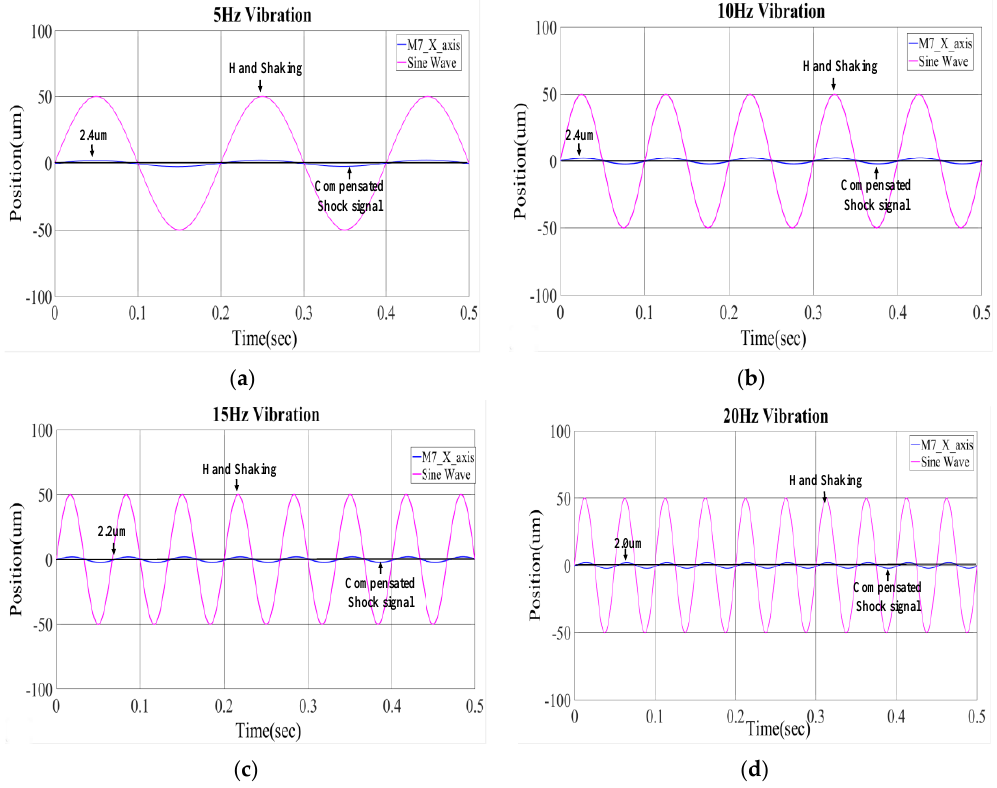
Figure 8. Simulated response of the lens holder motion relative to ground with the designed controller applied to the OIS; ( a ) 5 Hz disturbance in ±50 μm; ( b ) 10 Hz disturbance in ±50 μm; ( c ) 15 Hz disturbance in ±50 μm; ( d ) 20 Hz disturbance in ±50 μm.